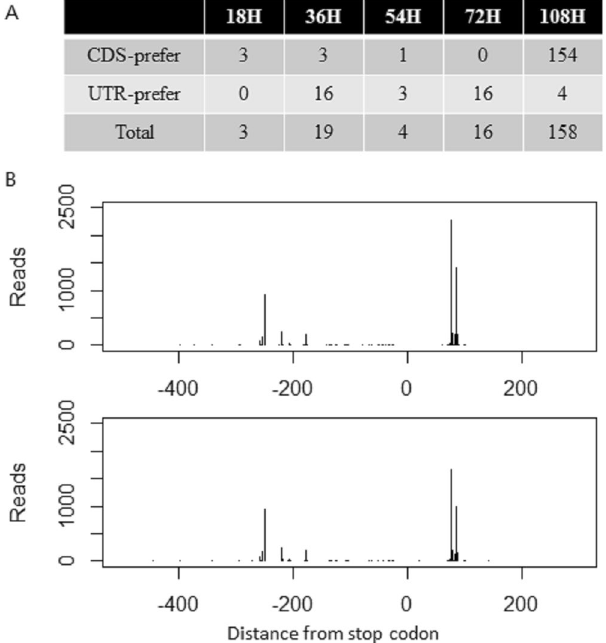
Figure 6. Genes with APA switching among coding region and 3 ′ UTR region. ( A ) Summary of genes with APA switching among coding region and 3 ′ UTR region between samples at different time points. ( B ) ATF4 occurred APA switching among coding region and 3 ′ UTR region at 18